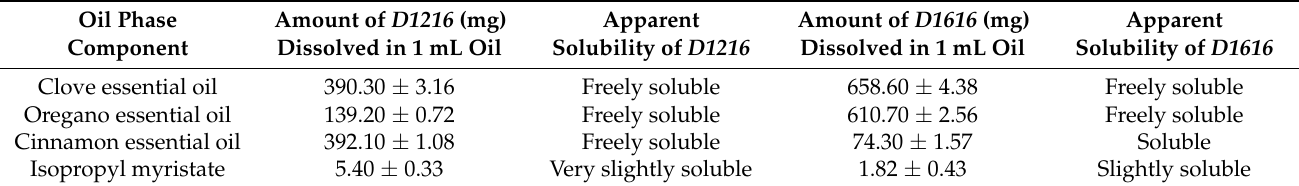
Table 5. The apparent solubility of sucrose laurate and sucrose palmitate in the oil phase components of the experimental